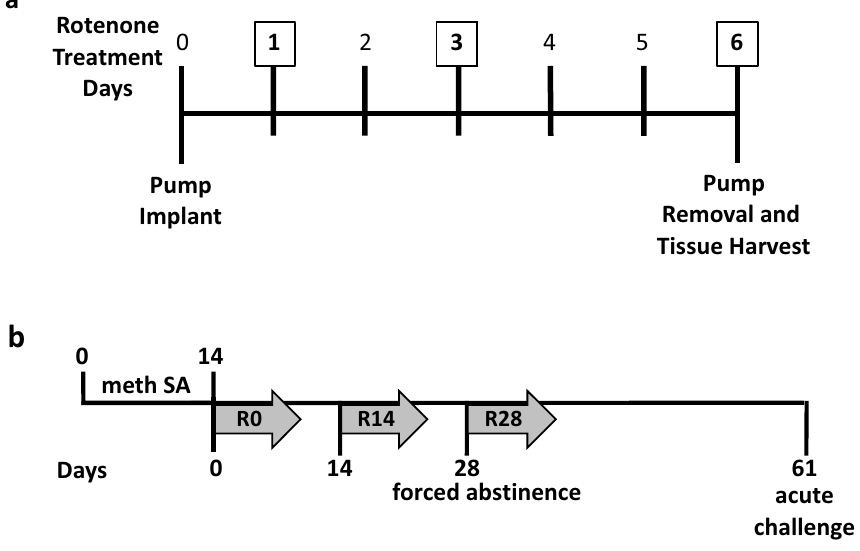
Figure 1. Study timelines. ( a ) Alzet® minipumps set to deliver vehicle, 1 mg/kg/day or 3 mg/kg/day of rotenone were implanted subcutaneously. Behavioral measures were conducted on days 1, 3 and 6 of treatment. Pumps were then removed and tissues were harvested at the end of treatment day 6. ( b ) Rats self-administered meth 3 h/day for 14 days via lever pressing or were non-contingently given meth via subcutaneous injection. Alzet® minipumps containing vehicle or 1 mg/kg/day of rotenone were implanted subcutaneously on meth forced abstinence day 0, 14, or 28. Pumps were then removed and tissues were harvested at the end of treatment day 6. Rats abstained from all treatment until forced abstinence day 61, which is when all rats were subcutaneously administered 1 mg/kg meth (meth acute challenge) and behavioral measures were collected. On forced abstinence day 62, rats were sacrificed and tissues were